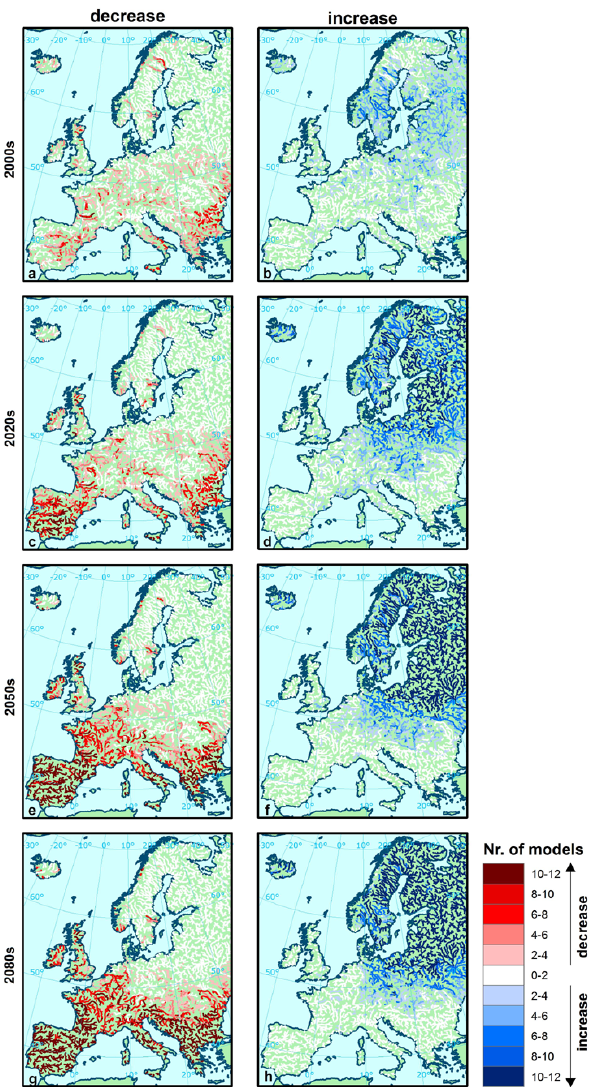
Fig. 10. Consistency of the streamflow drought simulations for dif- ferent time slices indicated by the number of simulations (out of 12) agreeing in a decrease (left) or increase (right) of more than 5% in minimum flows.